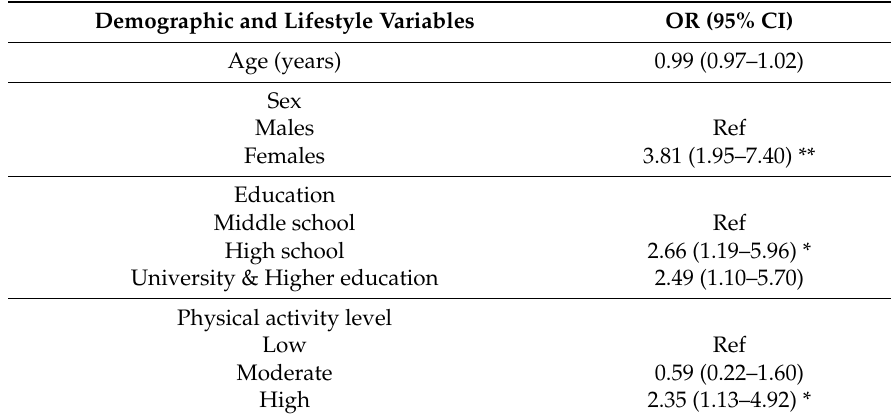
Table 2. Multiple logistic regression for the association between socio-demographic and lifestyle characteristics with MHOv/O in the study population ( n = 196).